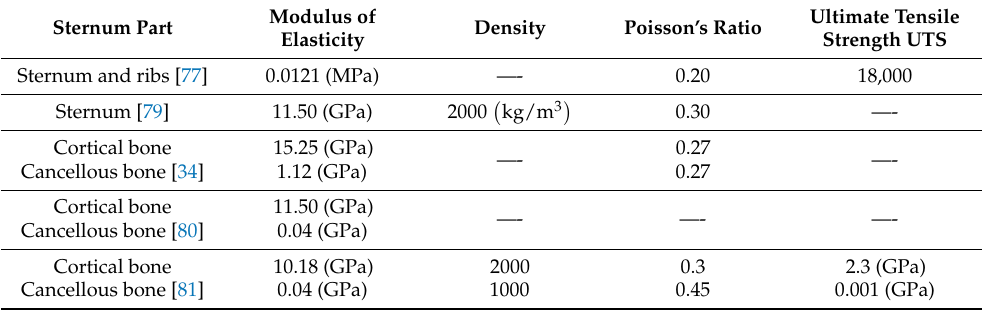
Table 3. Sternum modeling parameters for identifying biomechanical